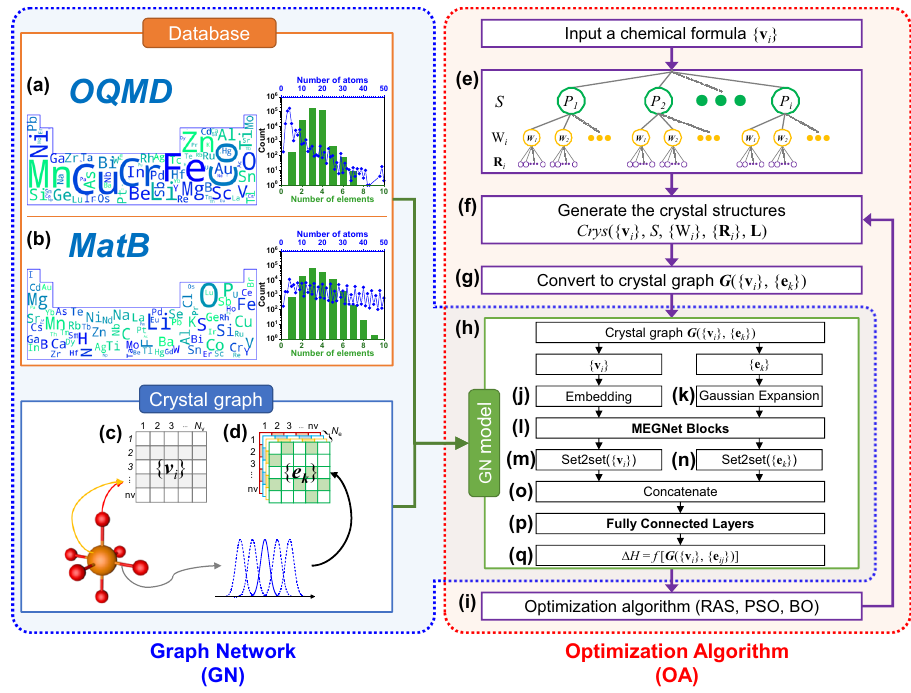
Fig. 1 Flowchart of GN-OA approach. Two databases, OQMD and MatB, have been separately used for training GN model and the elemental appearance, the distributions of number of elements and atoms in each database are shown in a OQMD and b MatB with quantitative number shown in Supplementary Figs. 1 and 2, respectively. For crystal graph, the input atomic feature is c embedded atomic number (from 1 to Nv) for each compositional atom (from 1 to nv) and d the pair feature is Gaussian-expanded distance (from 1 to Ne) for each pair connecting atom ( i ) (from 1 to nv) and ( j ) (from 1 to nv). The structural generation part includes e symmetry constraint, f structural generation, g crystal graph conversion. The GN model h combines j embedded atomic number, k Gaussian-expanded pair distance, l the MEGNet blocks, the set2set layers for m atomic number and n pair distance, o concatenate layer, p fully connected layer to obtain q the correlation model between a crystal and its formation enthalpy. i Optimization algorithm block.